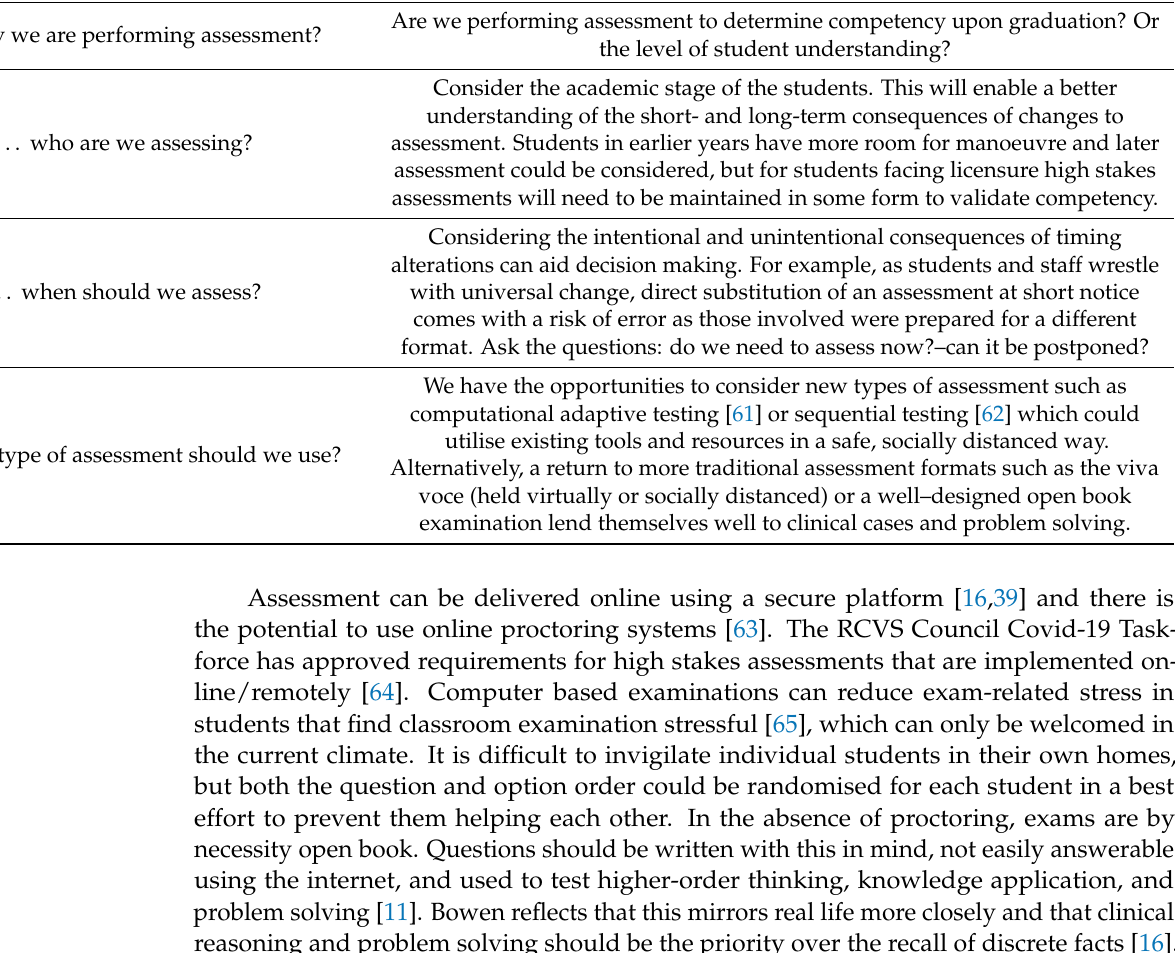
Table 1. Rethinking the why, who, when and what of assessment in the face of the Covid-19 pandemic adapted from Fuller et al. (2020) [11]. Rethinking . .